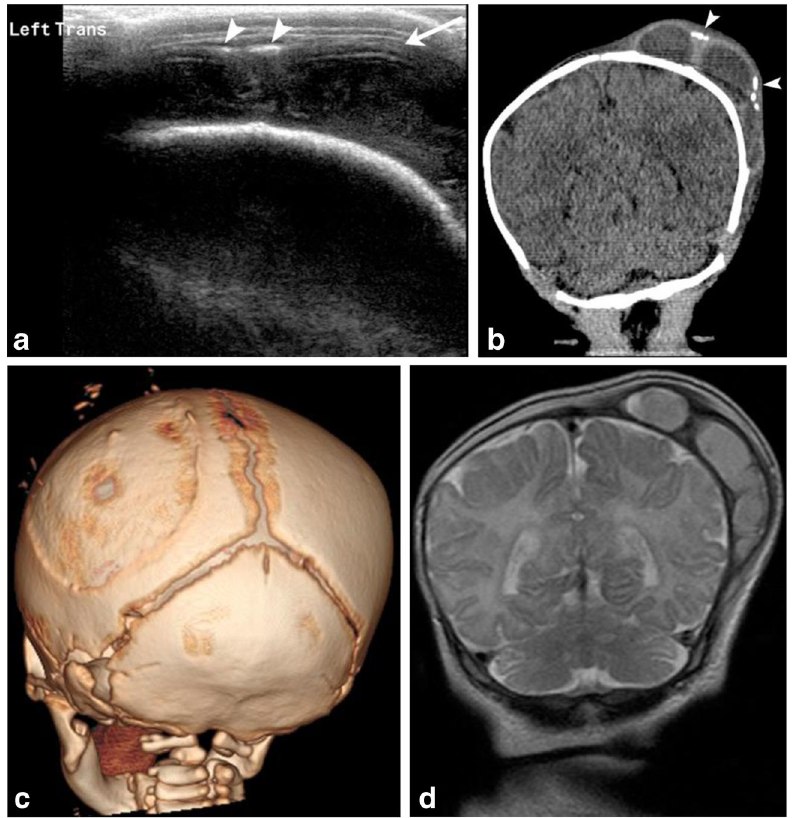
adjacent sagittal or the lambdoid suture, suggestive of cephalhematoma. 3-D volume (c) rendered images in bone algo- rithm shows cortical irregularity along the left parietal bone at the site of cephalhematoma as well as peripheral calcifications along the superficial aspect of the cephalhematoma. Coronal T2 image (d) from an MR exam obtained one week later in the setting of patient ’ s seizures re-demonstrates the large subperiosteal complex fluid collection with thick septations and isointense fluid signal consistent with evolving blood products in the known left parietal